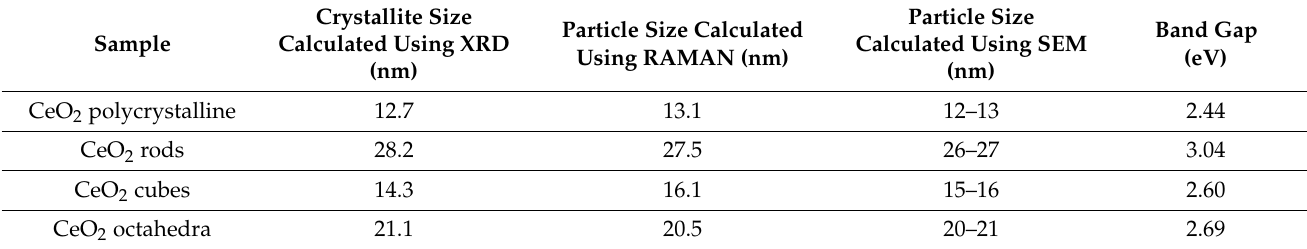
Figure 3. UV-Vis absorption spectra of the prepared cerium dioxide shapes and optical band gap determination from Tauc plots. Table 2. Calculated values of particle size and band gap of cerium dioxide